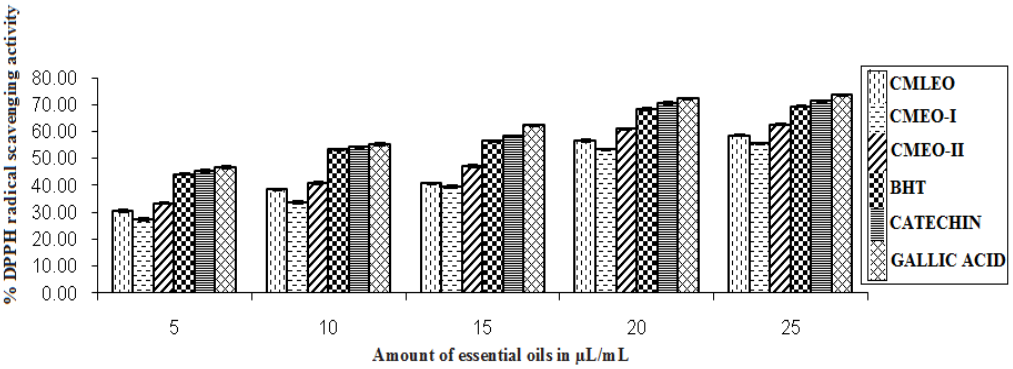
Figure 3. DPPH radical scavenging activity.